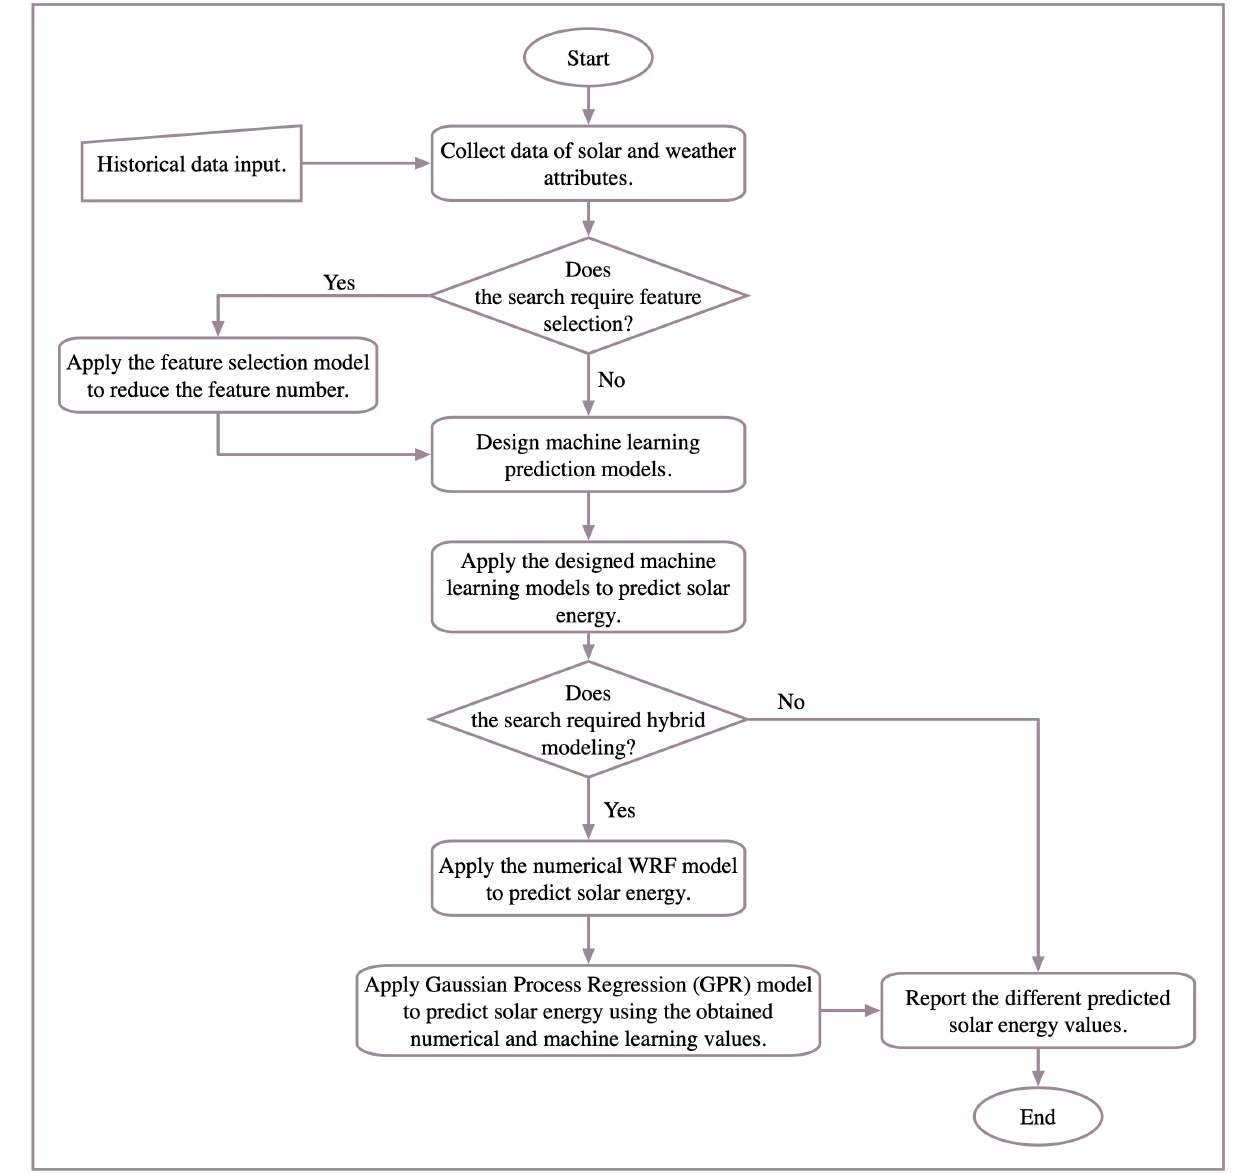
Figure 1. The flowchart of the proposed solar prediction